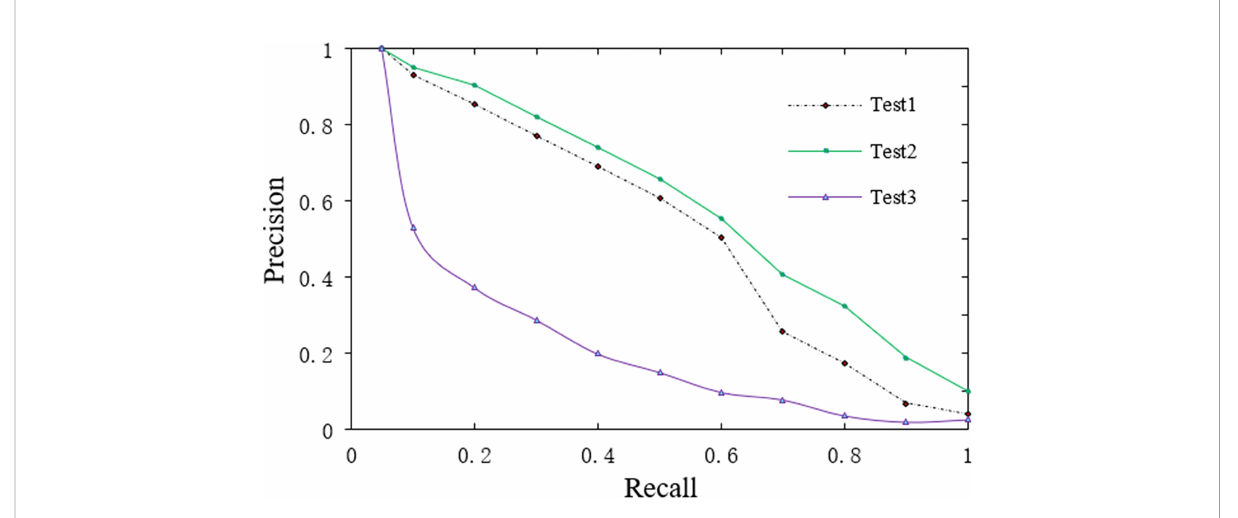
FIGURE 3 Precision-recall curve of Chinese roses ’